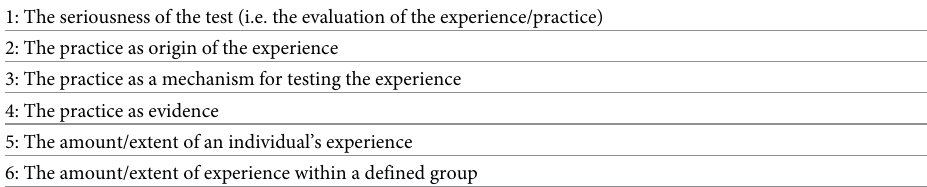
Table 1. Dimensions of proven experience according to [17,